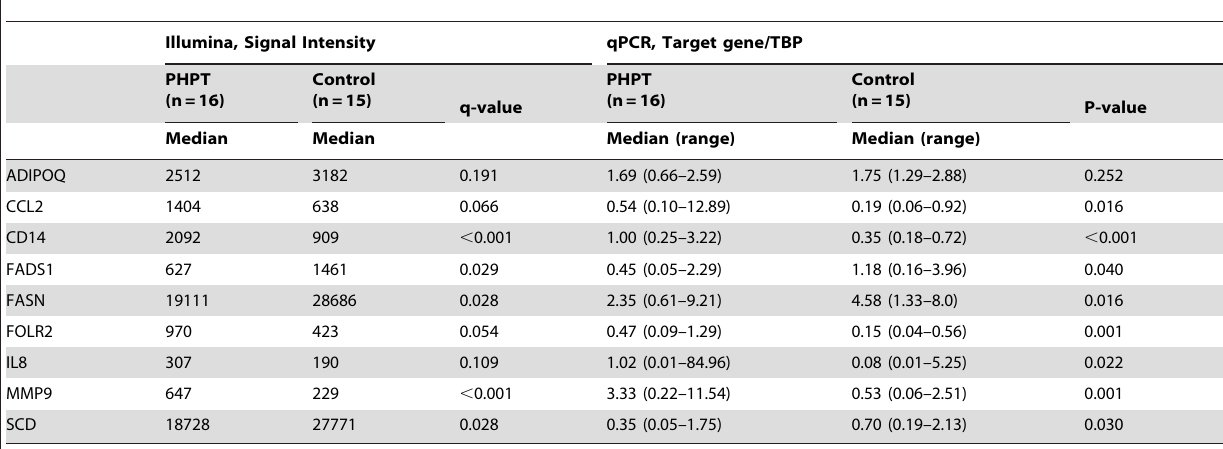
Table 4. Validation of selected genes by